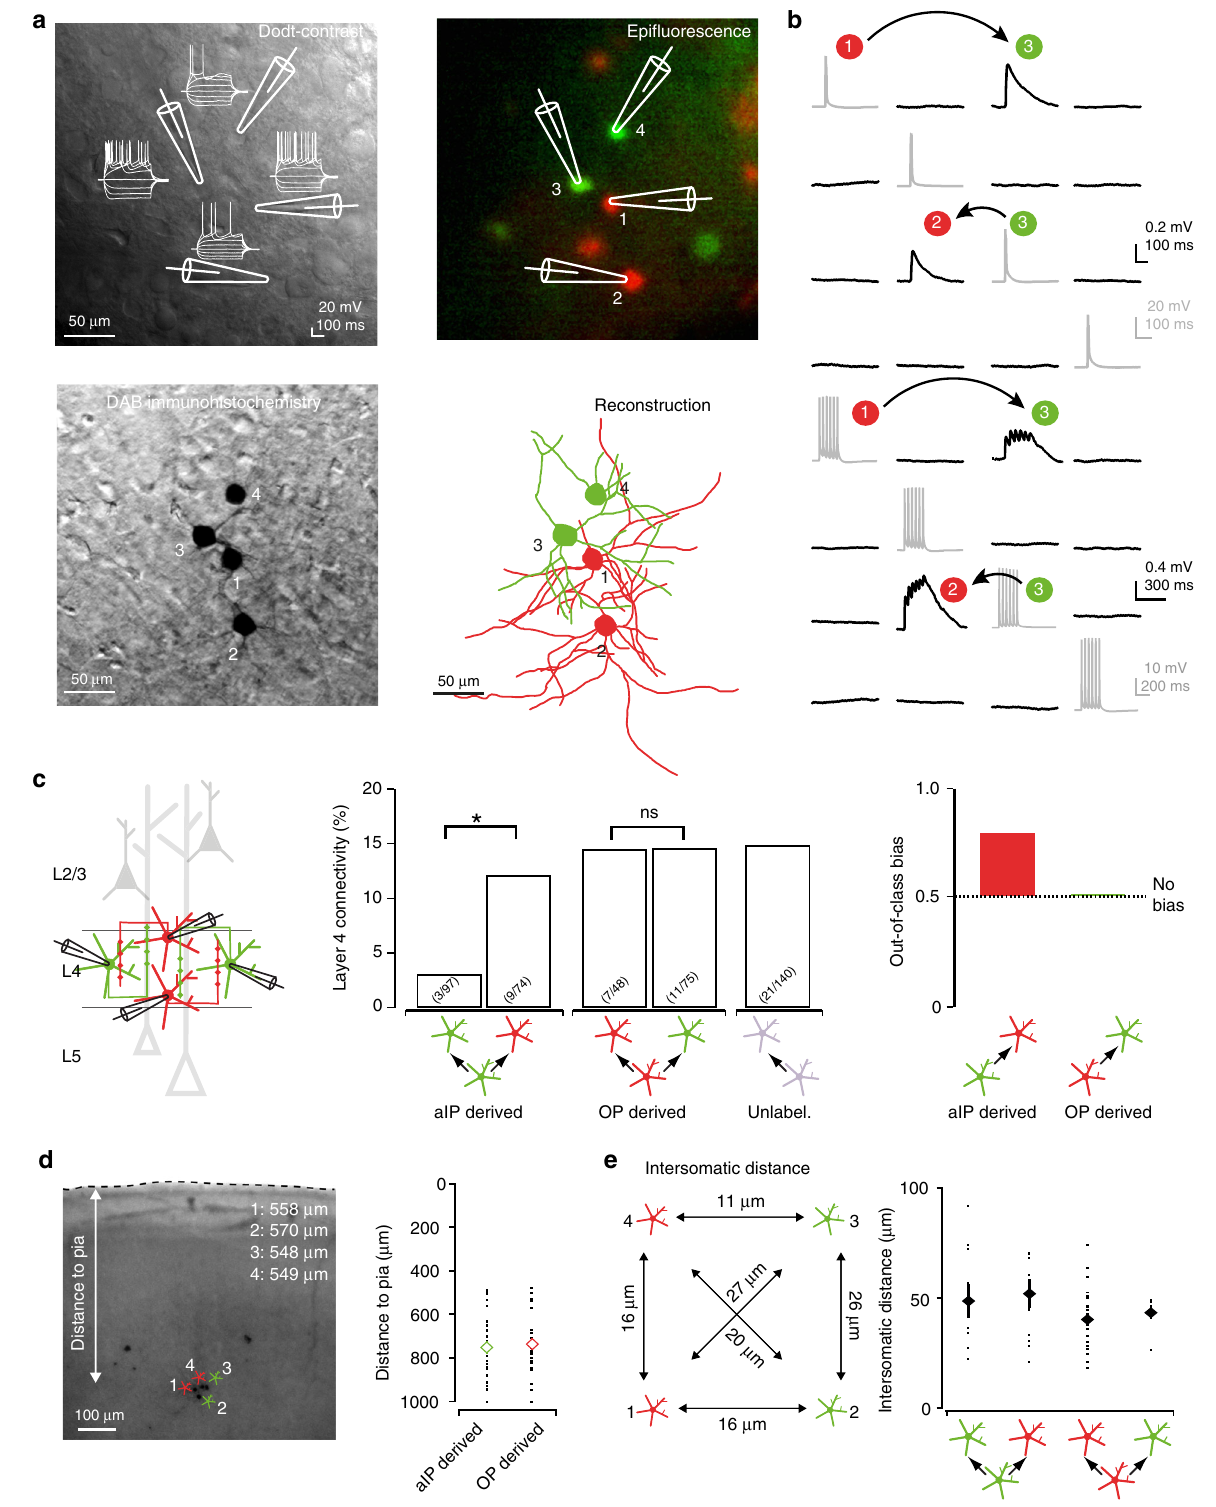
Fig. 4 aIP-derived L4 neurons exhibit selective intralaminar connections. a Quadruplet whole-cell patch-clamp recording from aIP- and OP-derived neurons in L4 of S1. b Intralaminar connectivity was assessed with single (top) and trains (bottom) of pre-synaptic action potentials. c aIP-derived L4 spiny stellate neurons exhibited a higher probability of connecting to neighboring L4 neurons that were derived from OPs (aIP to aIP: 3.1%, aIP to OP: 12.2%, OP to OP: 14.6%, OP to aIP: 14.7%; aIP to OP: p = 0.03, Fisher ’ s exact test). This represents an ‘ out-of-class ’ connectivity bias for aIP-derived neurons, where a value of 0.5 indicates no bias. d Recorded aIP- and OP-derived neurons had comparable distances from the pial surface ( p = 0.7, t -test, n = 28 and 26). e Intersomatic distances were similar for each category of cell-cell comparison ( p = 0.5, Kruskal – Wallis test, n = 10, 12, 23, and 7). Error bars represent standard error of the mean. Source data are provided as a Source Data fi